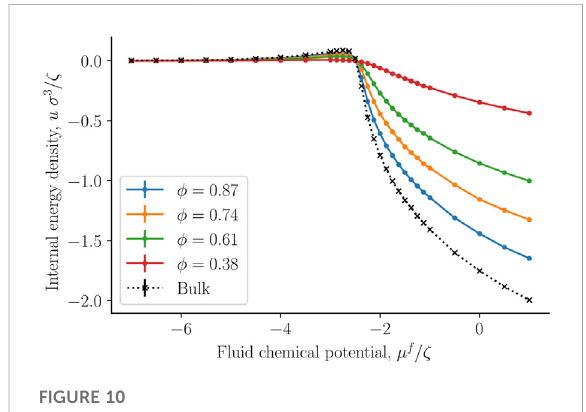
FIGURE 10 Internal energy density u = U / V as a function of the fl uid chemical potential μ f for varying porosities ϕ = V f / V .